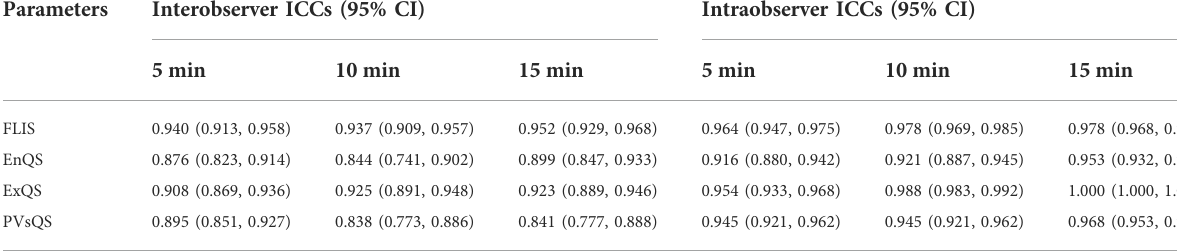
TABLE 4 Intra- and inter-observer agreement for FLIS and the three FLIS parameters at different time points. Parameters